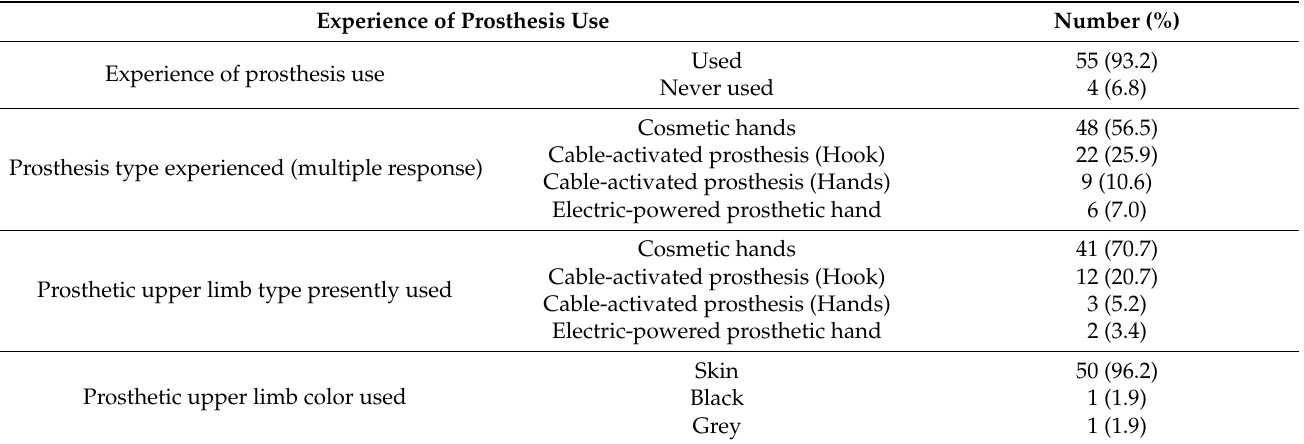
Table 2. Experience of prosthesis use ( n = 59).